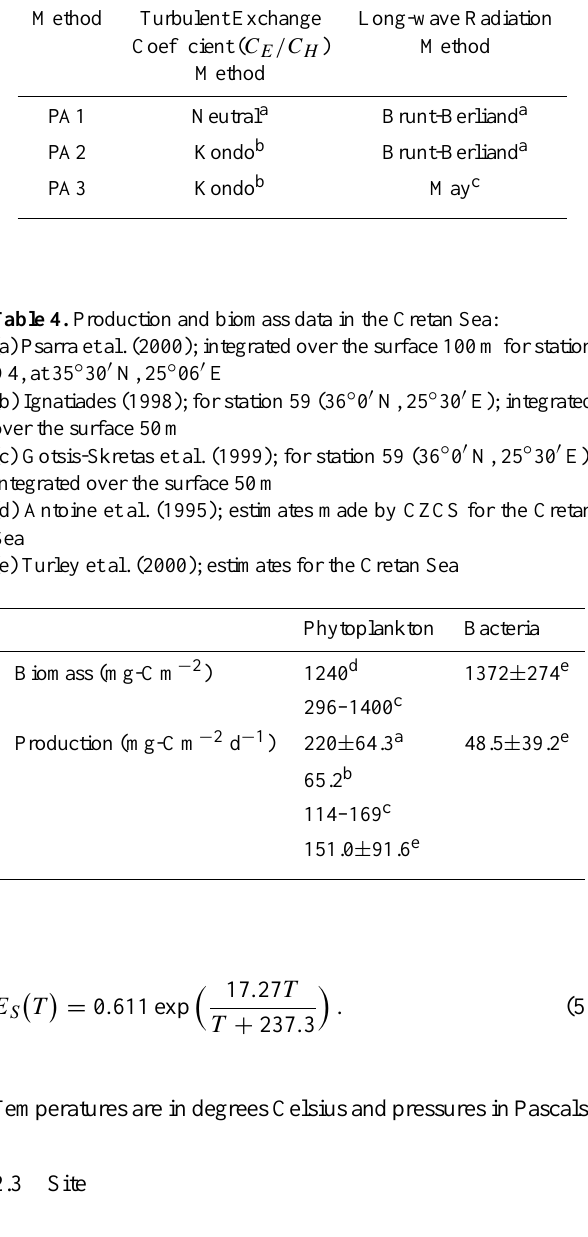
Table 5. Nutrient data in the Cretan Sea, and annually averaged nutrient concentrations (depths 0–250m) for the model simulations PA1, PA2 and PA3: (a) Tselepides et al. (2000); for stations in the Cretan Sea in depths of more than 500m; annual averages of samples taken from depths